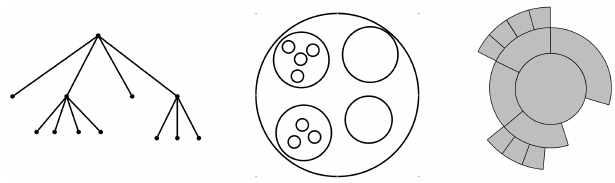
Figure 2. Tree layouts, Node-link (explicit), Nested (implicit) and Adjacency